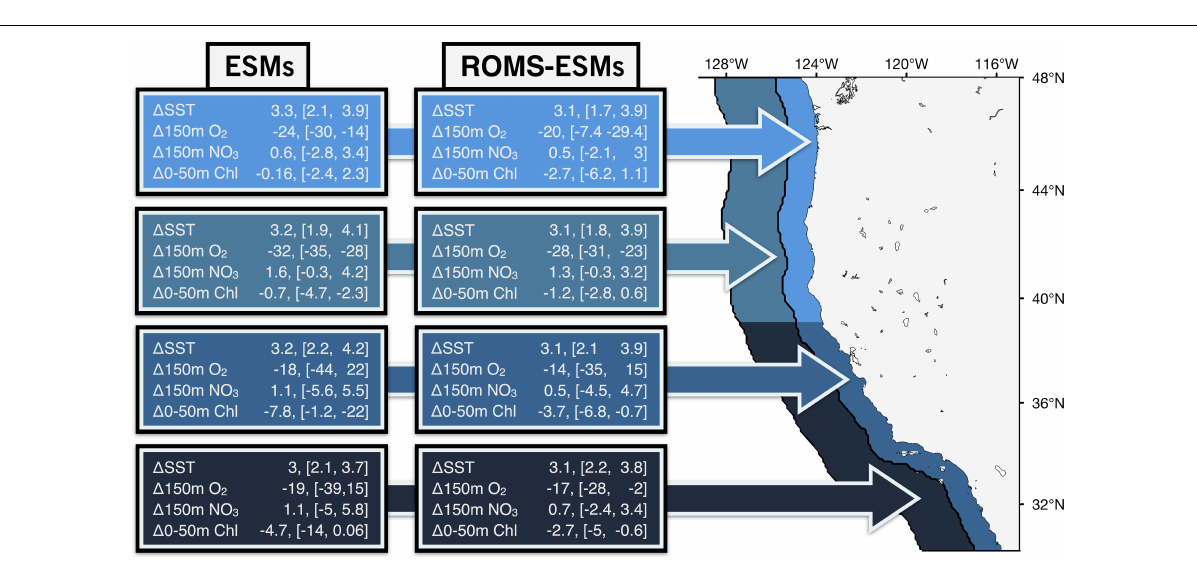
of climate change projection. We discuss these points